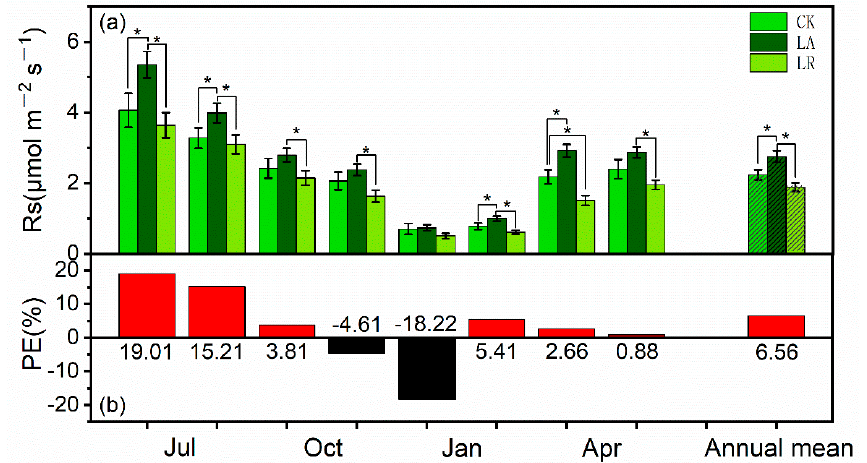
Figure 2. The average Rs of the N0-N3 plots in different litter treatments ( a ) and priming effects (PE) ( b ) in different incubation periods. The error bar indicates mean ± SE ( n = 12). Asterisks (*) indicate significant differences ( p < 0.05). The red and black columns show the positive and negative PE.